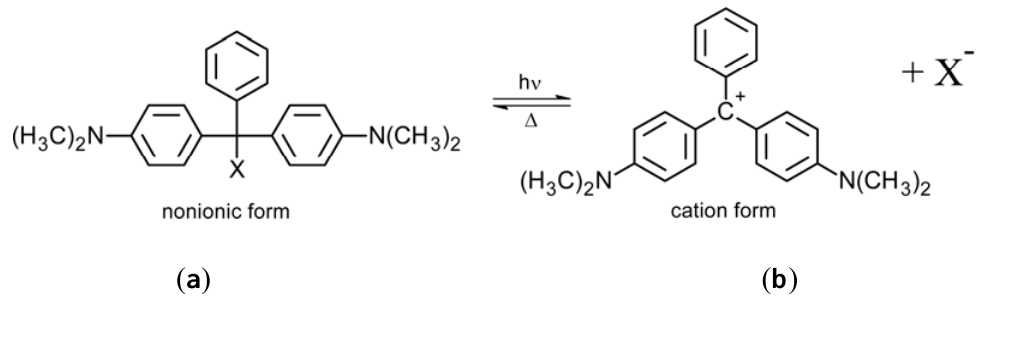
Figure 2. Photo-induced structure change of a triphenylmethane molecule: ( a ) non-ionic form, and ( b ) cation form.